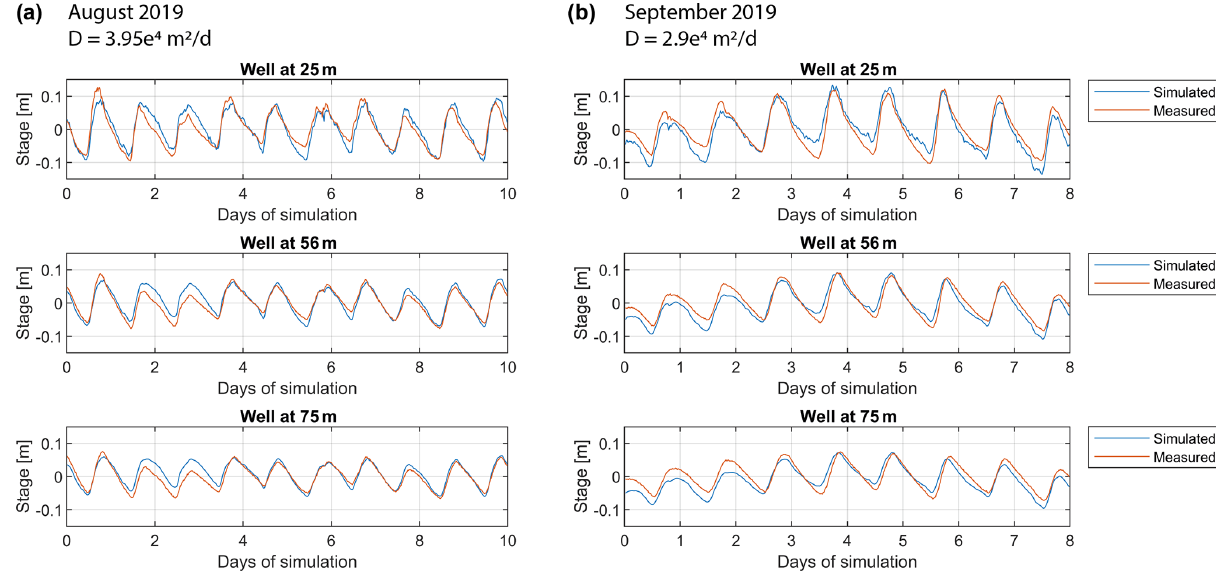
Figure A1. Measured and simulated water head variations for piezometers along the downstream transect “ B ” for the best calibration of the diffusion parameter D and for (a) the high-flow condition in August 2019 and (b) lower-flow condition in September 2019.